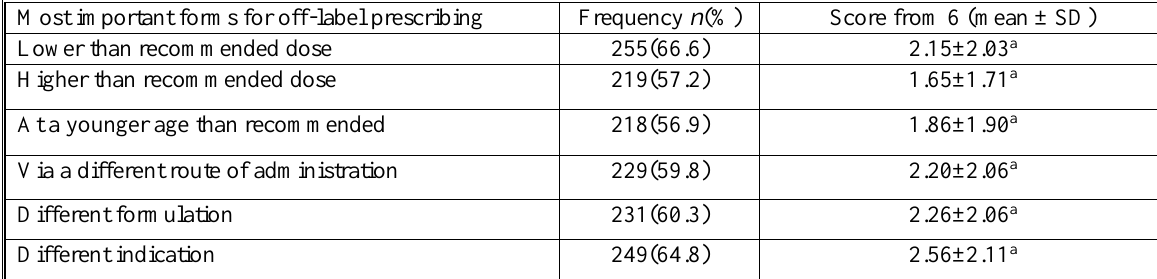
Table 1. Forms of off label-drugs